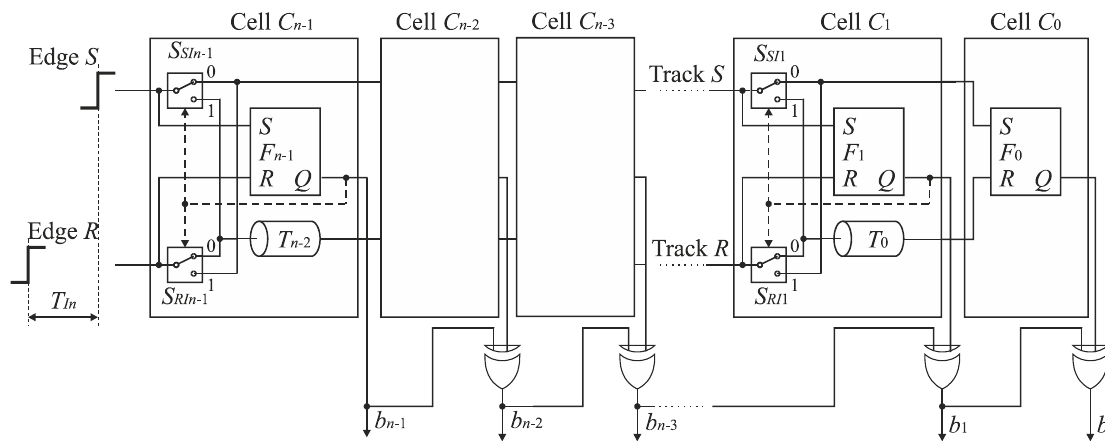
Figure 19. Architecture of n -bit feedforward SA-TDC with single set of delay lines and output decoding.